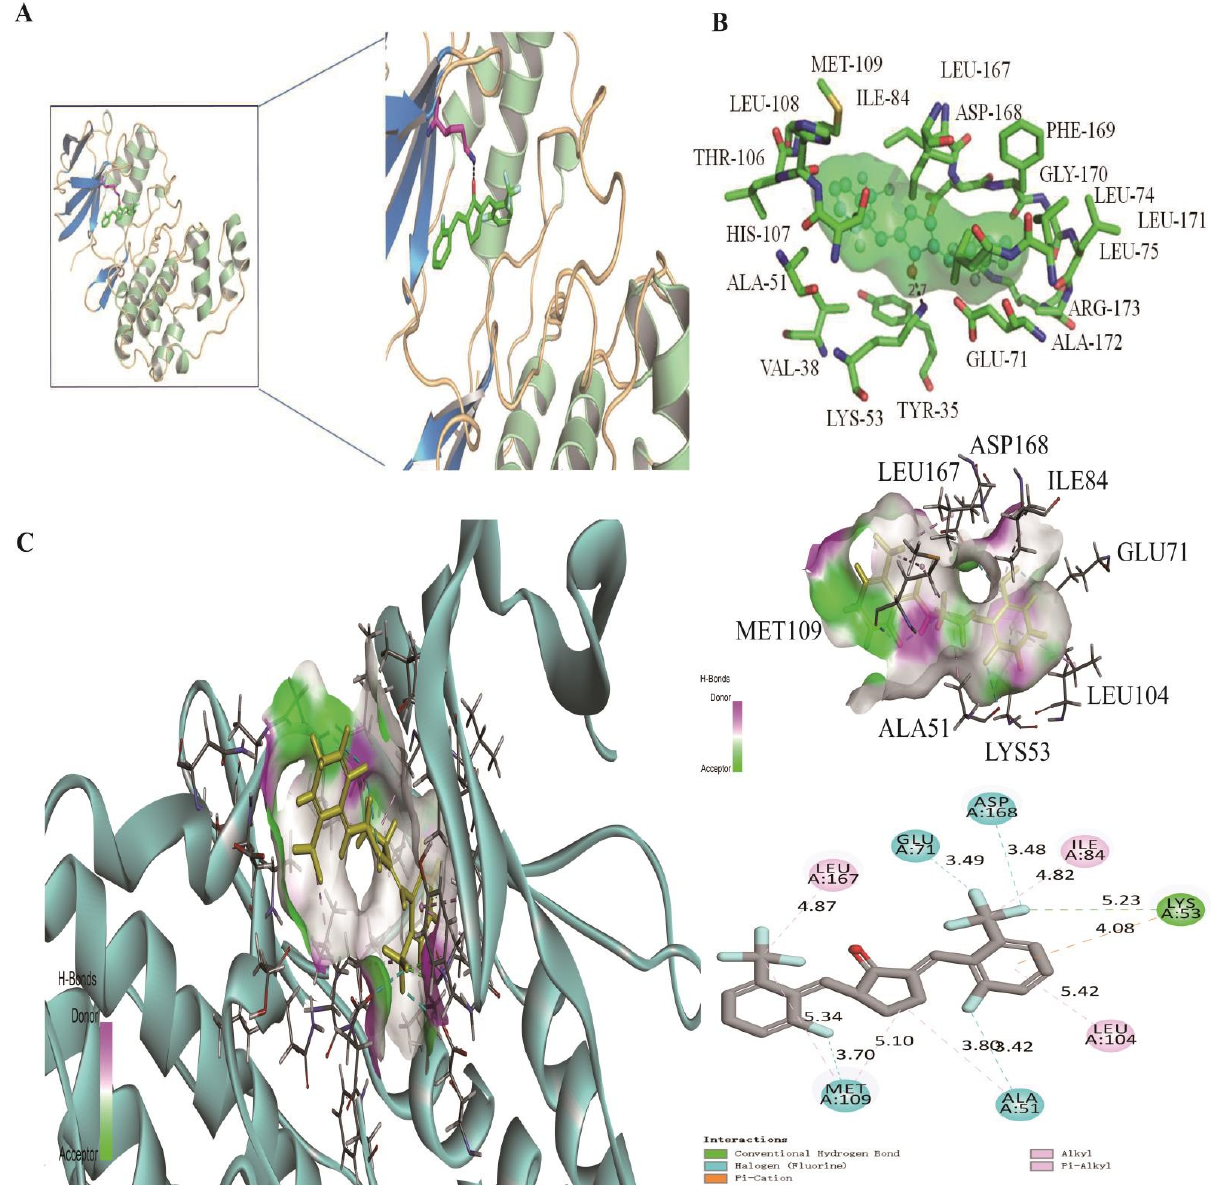
Figure 4. Molecular docking of H8 on the 1BL7 protein. ( A ) Modeling of H8 docking to 1BL7 was simulated with Pymol, and positions of H8 are shown in pink within the active site of 1BL7. ( B ) The green dashed line indicates a possible hydrogen bond between the connected residues and the ligand. ( C ) Modeling of H8 docking to 1BL7 was simulated with Discovery studio software (3D and 2D, San Diego, CA, USA; https://discover.3ds.com/discovery-studio-visualizer-download, accessed on 22 August 2022). All the data showed that H8 could interact with the 1BL7 protein.